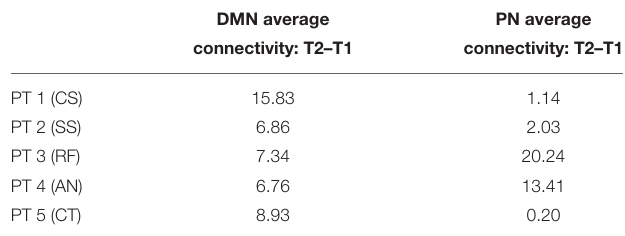
TABLE 3 | Average connectivity of the DMN and